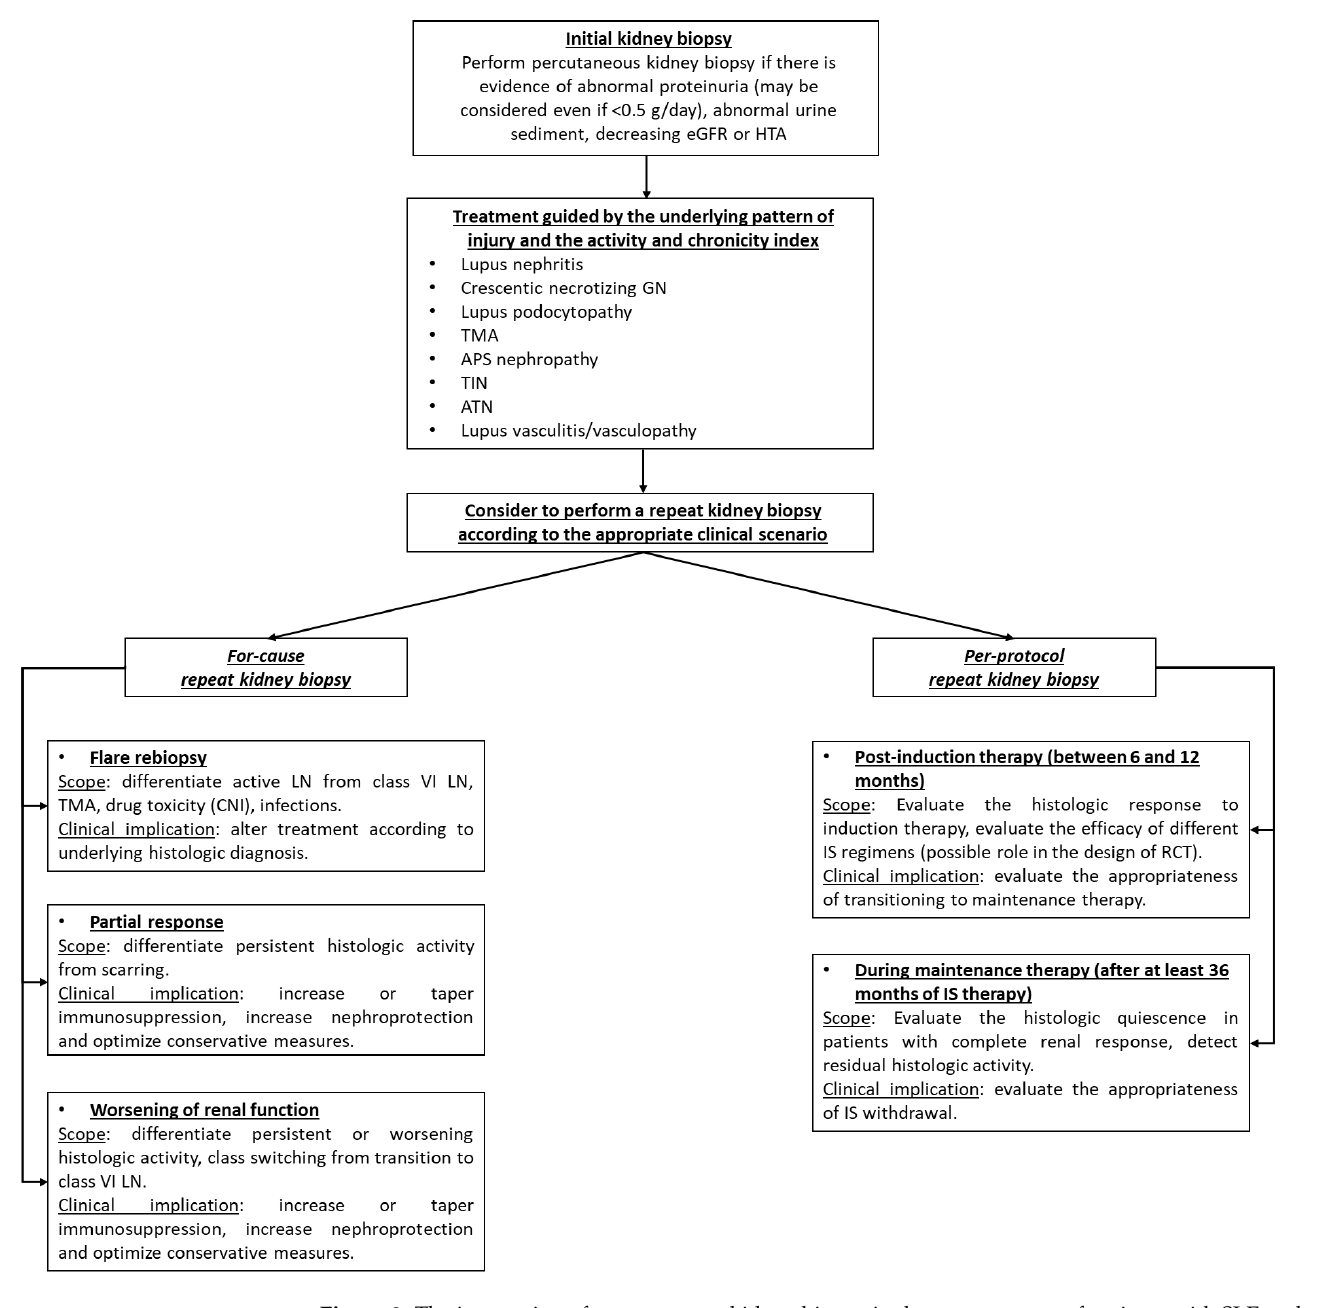
Figure 2. The integration of percutaneous kidney biopsy in the management of patients with SLE and renal involvement (adapted after [2,10,30,31,50,79,80]) (abbreviations: GN, glomerulonephritis; TMA, thrombotic microangiopathy; TIN, tubulo-interstitial nephritis; ATN, acute tubular necrosis; APS, anti-phospholipid syndrome; LN, lupus nephritis; CNI, calcineurin inhibitor; IS, immunosuppression; and RCT, randomized clinical trial).